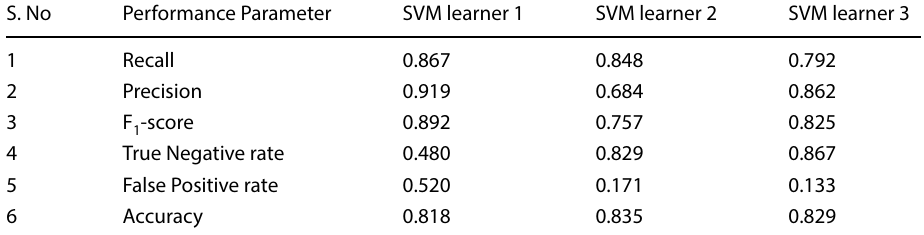
Table 7 Performance parameters of the SVM learners